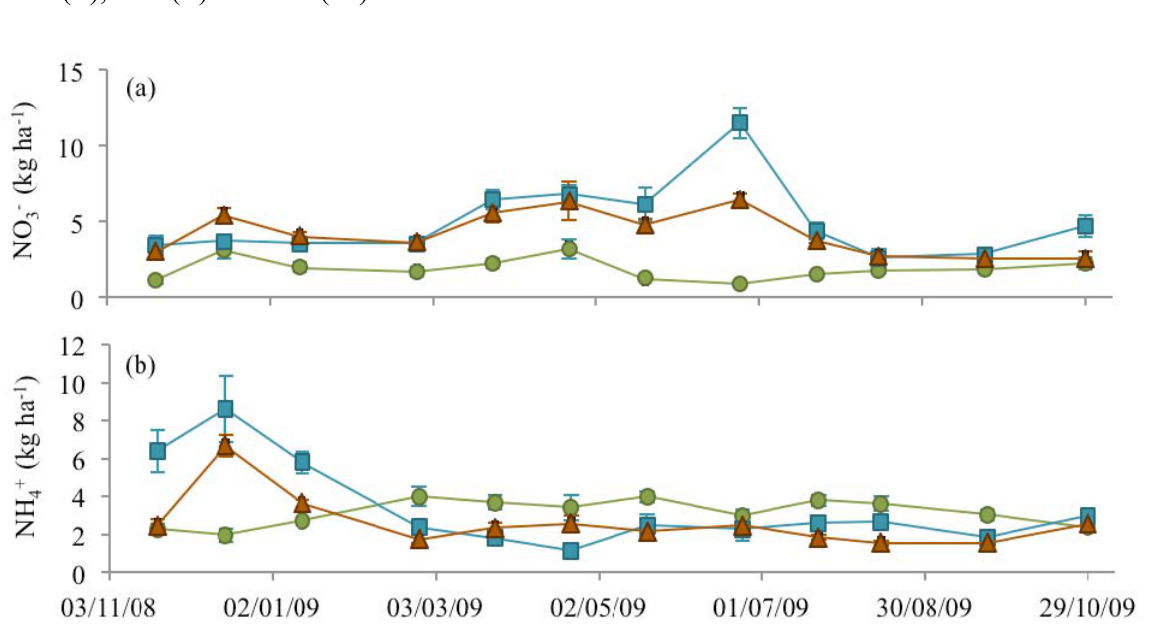
− and ( b ) NH 4+ (kg ha − 1 ) ± SE (n = 8) from three land uses: Figure 5. Mean ( a ) soil NO 3 G ( ● ), NM ( ■ ) and EM ( ▲